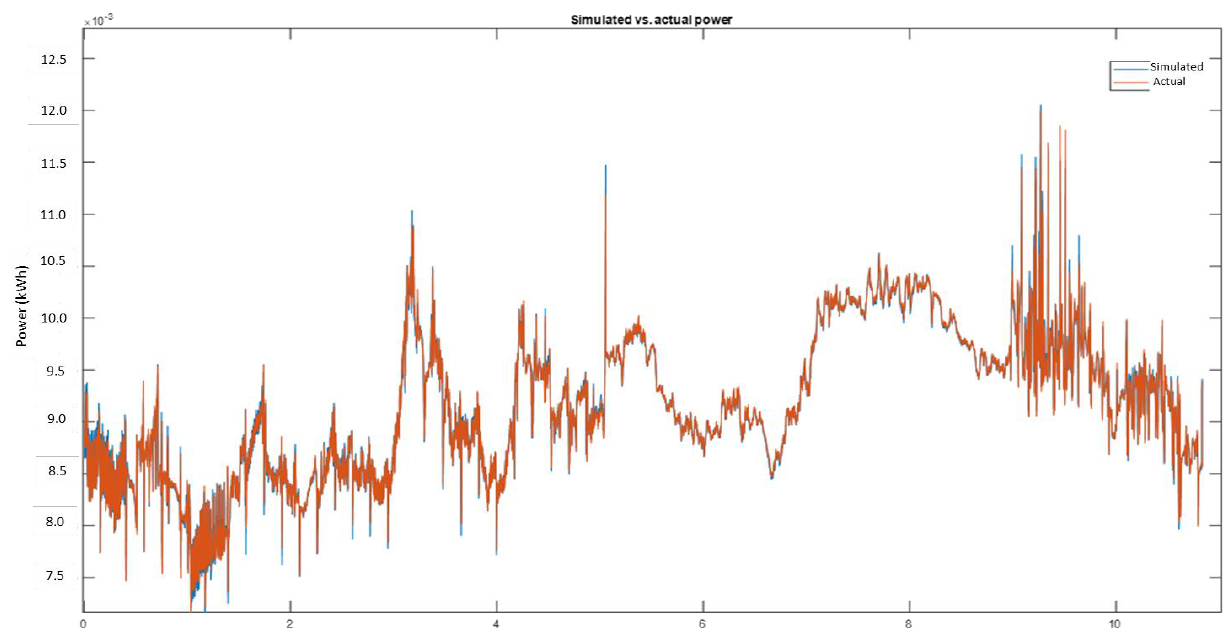
Figure 3. Optimal results with simulated power vs. actual power for the testing period of 10 days.